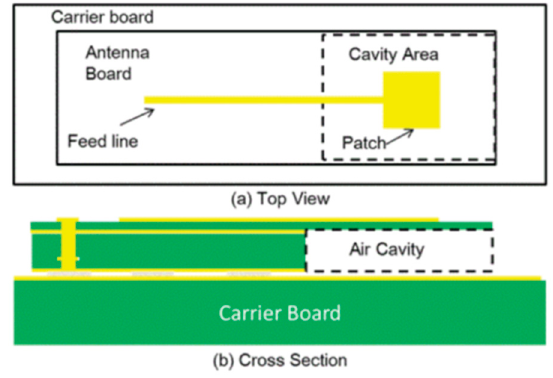
Figure 2. ( a ) Top view and ( b ) cross section view of the patch antenna.